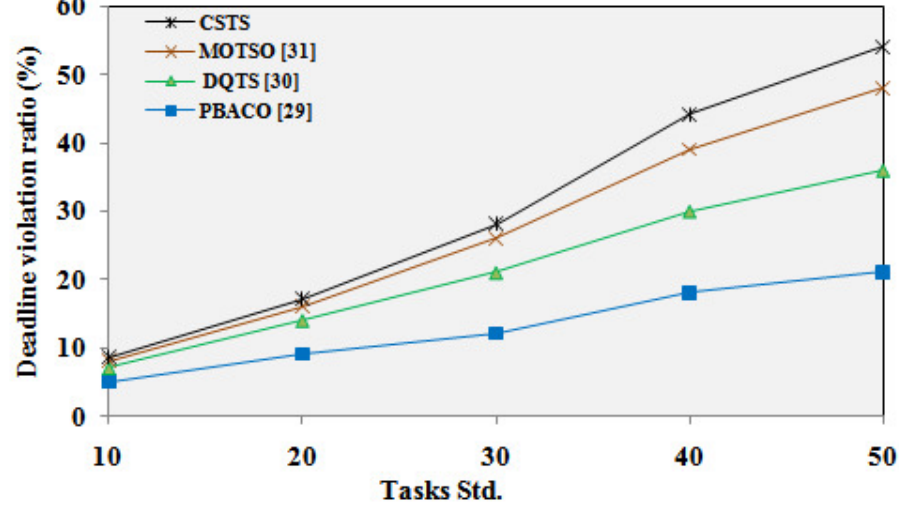
Figure 8. Deadline violation rate with task standard format.